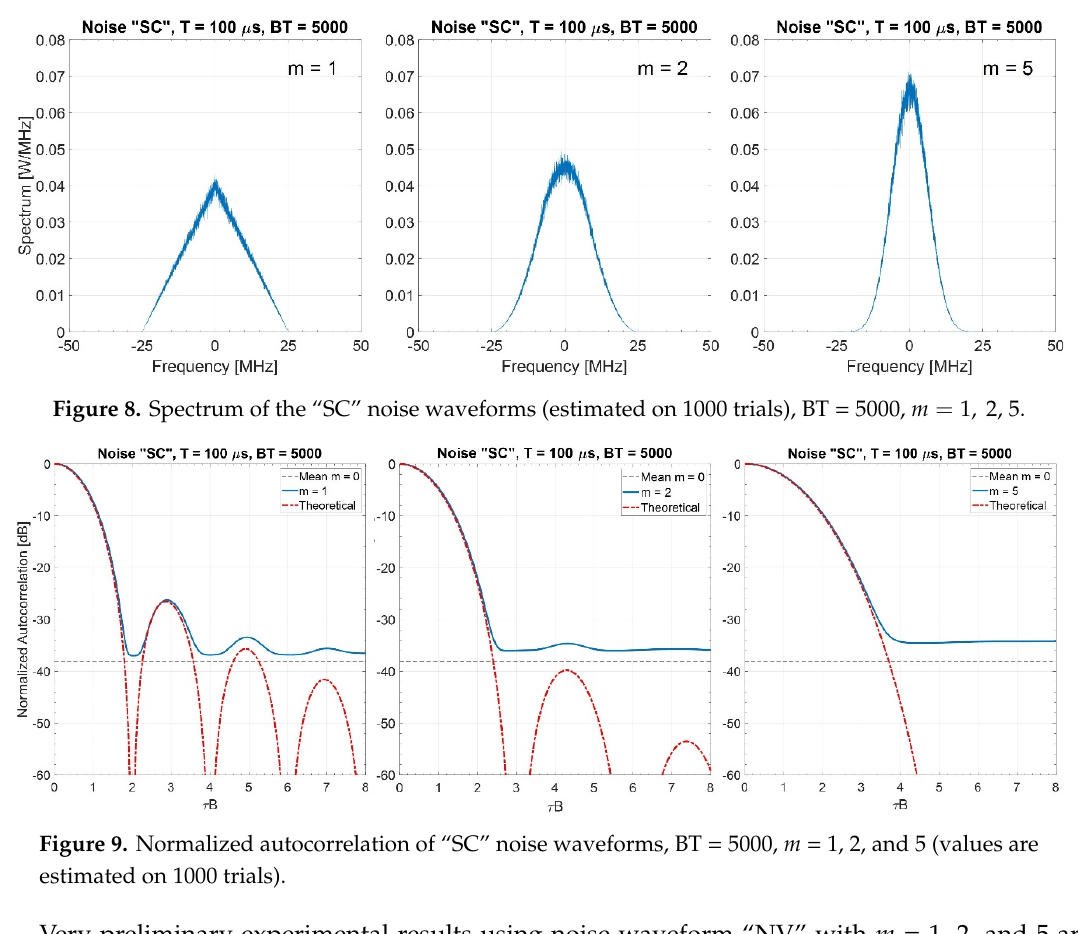
Rectangular, Hamming, and Blackman-Nuttall.